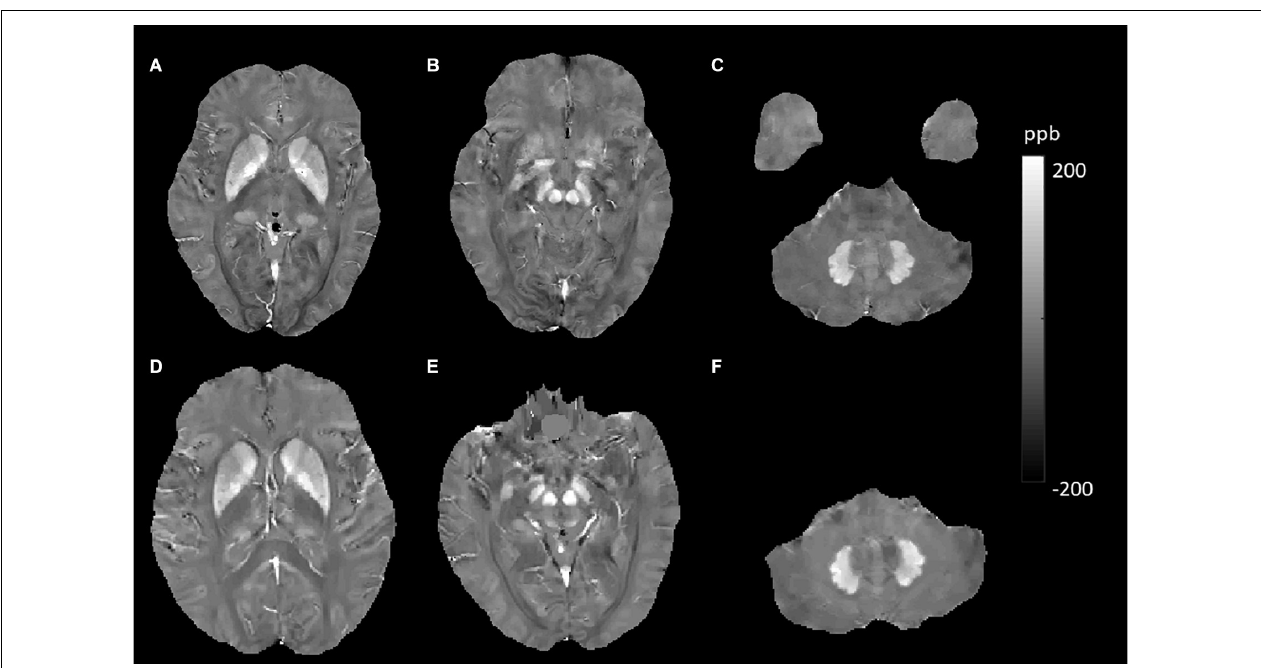
FIGURE 5 | Evolution of susceptibility values with age in the caudate nucleus, putamen, globus pallidus, red nucleus, substantia nigra, and dentate nucleus. These images were from a 64-year-old female non-smoker without hypertension and type 2 diabetes mellitus (T2DM). The upper row (A–C) shows quantitative susceptibility mapping (QSM) images acquired in 2011, and the bottom row (D–F) shows QSM images acquired in 2019. Susceptibility values of the gray matter nuclei increased significantly over time.